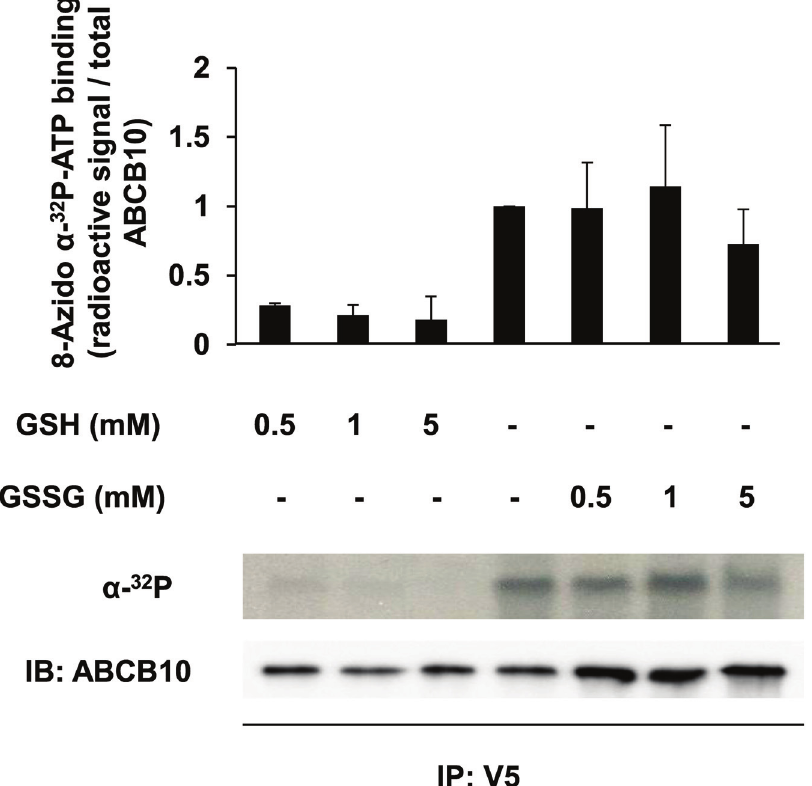
Fig 6. GSH, but not GSSG, specifically decreases ABCB10 ATP binding activity. A representative autoradiography image and the quantification shown in the bar graph demonstrate that GSH decreased [ α - 32 P] 8-azido-ATP signal in ABCB10 from SMPs in a dose dependent manner, whereas GSSG did not. Bar graphs represent mean ± SD from independent